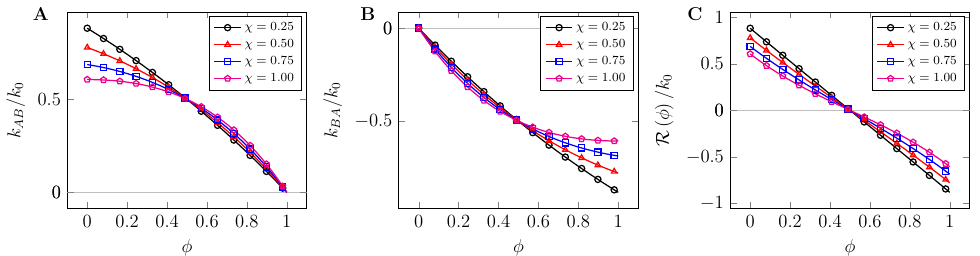
Figure 4. Relative dissipative state-dependent reaction rates plotted against volume fraction: ( A ) the relative forward reaction rate k AB / k 0 decreases with increasing volume fraction due to decreased mobility; ( B ) similar observation is true for k BA / k 0 which increases with increasing crowder volume ( φ ) , which effectively reduces to zero at fraction; and ( C ) overall contribution of the reaction rates, R the equilibrium condition of the chemical potential. See the text for more